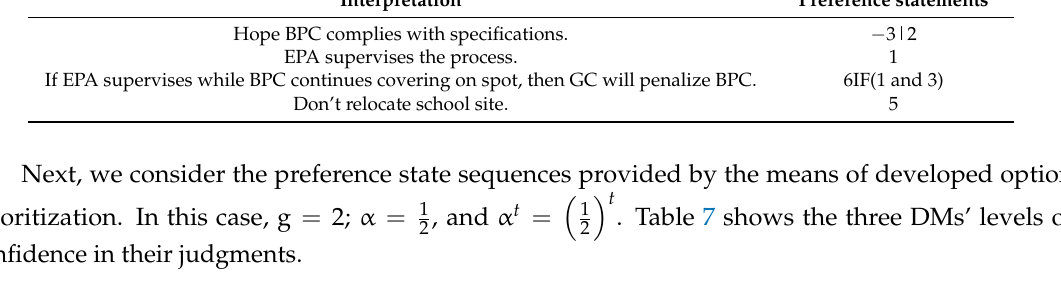
Table 7. C of Preference Statements of DM1, DM2 and DM3.